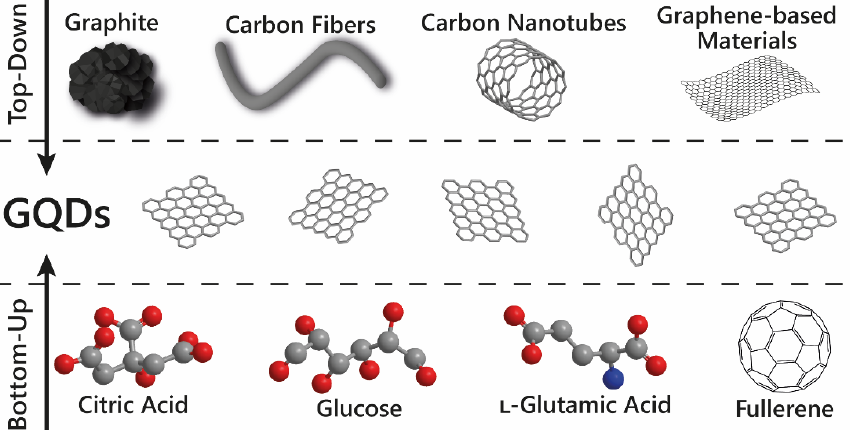
Figure 1. Top-down and bottom-up routes employed to synthesize